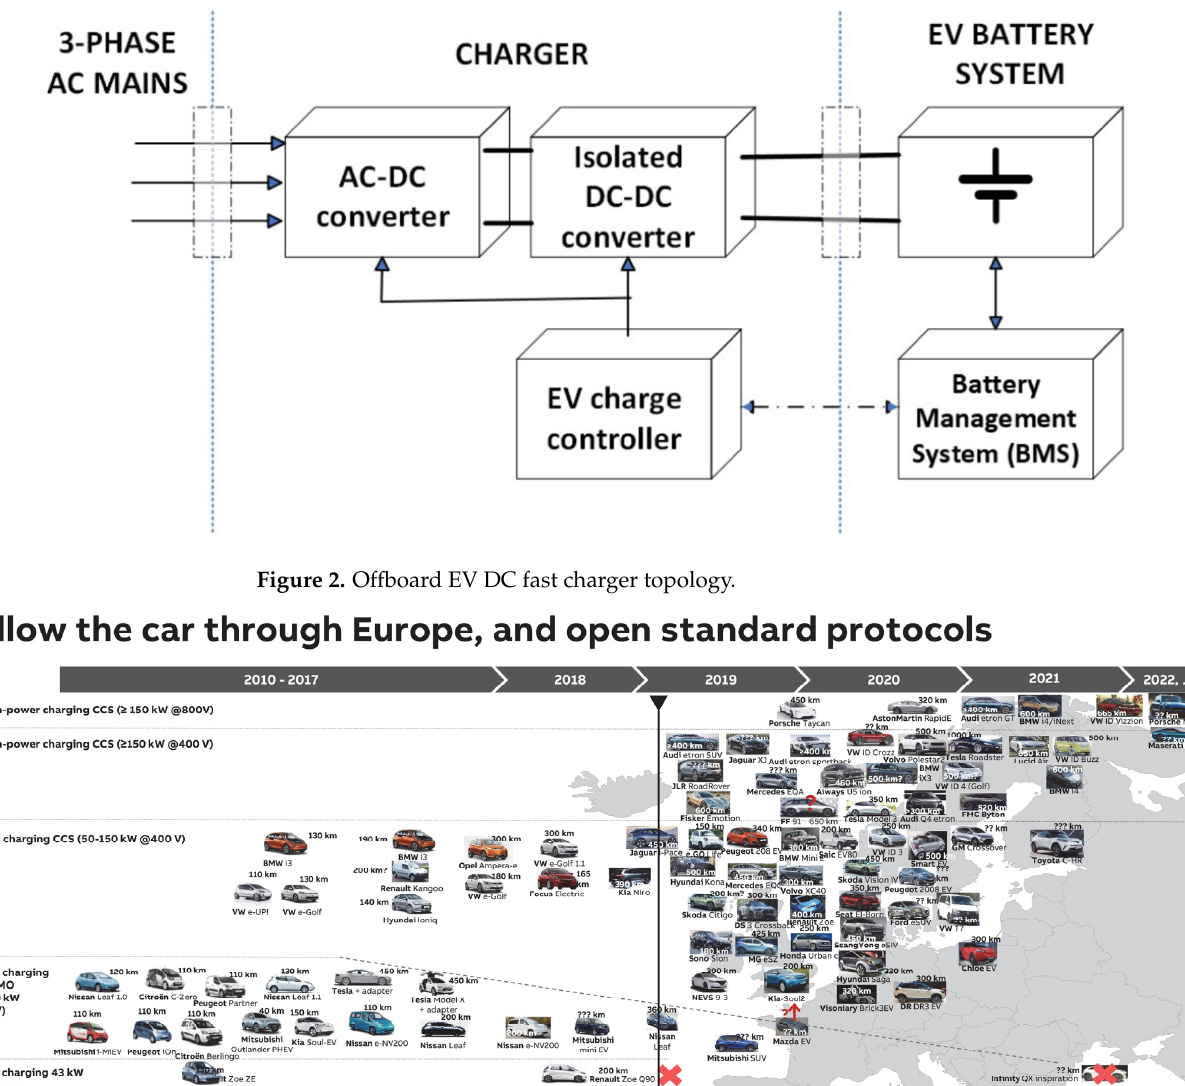
Figure 2. Offboard EV DC fast charger topology.